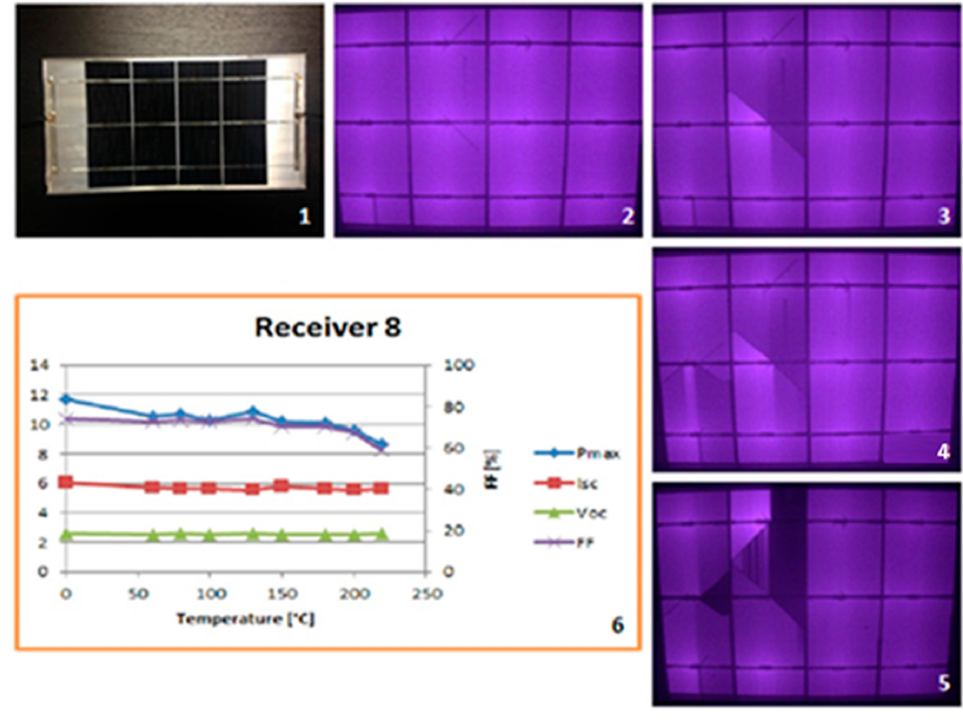
Figure 16. ( 1 ) Receiver 8; ( 2 ) Baseline Round; ( 3 ) Round 5 (150 °C); ( 4 ) Round 6 (180 °C); ( 5 ) Round 8 (220 °C); ( 6 ) Parameters of the IV curve at different temperatures (Isc, Voc and Pmax shown in the left Y axis and FF in the right Y axis).